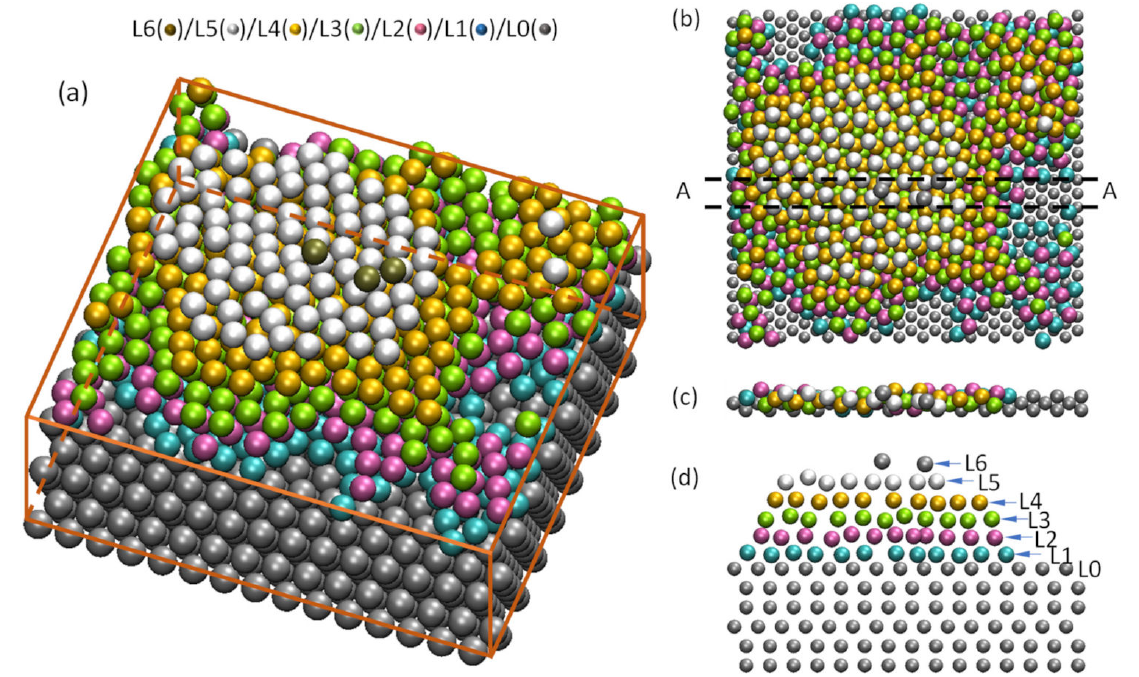
Figure 7. Ordered structure at the end of heterogeneous nucleation. ( a ) A 3D view and ( b ) a top view of the arrangement of solid atoms on the substrate at the end of heterogeneous nucleation ( t = 50 ps and T n = 760 K) in the system with − 8% misfit showing a 2D ordered structure as a consequence of structural templating; ( c ) a top view and ( d ) a front view (A-A slab section) of ( b ) showing the arrangement of solid atoms in the S/N interface (L1–L3) and the diffuse L/S interface